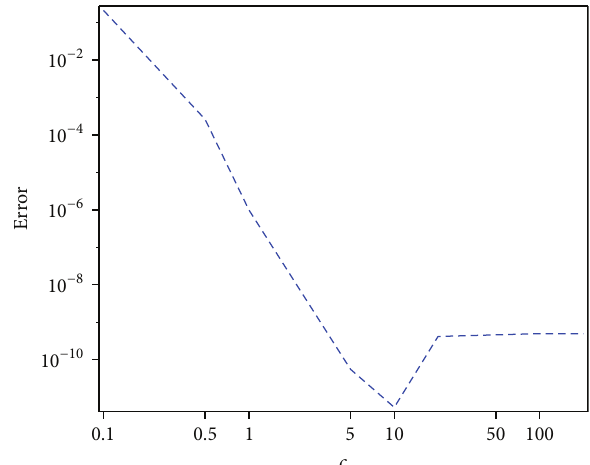
Figure 2: The horizontal axis is related to 𝑐 or shape parameter and the vertical axis shows the corresponding error values where 𝑛 = 49 . The relation between 𝑐 and log (error) is linear in the interval (0, 10) . Although the trend is changed, the graph confirms 𝑐 can affect error exponentially. In brief, the error function is sensitive to 𝑐 intensively. The data is related to Example 1.